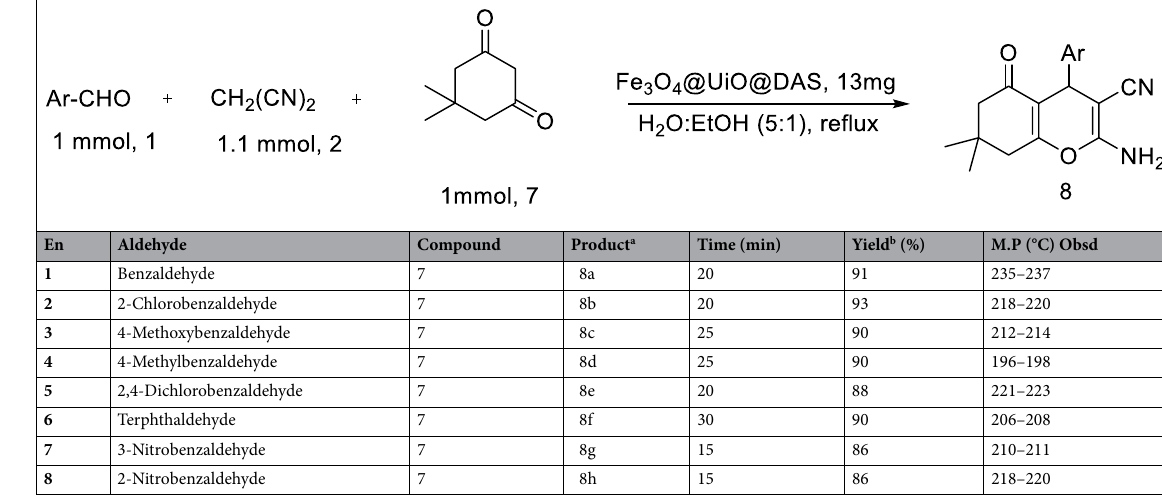
Table 5. Three-component synthesis of different 4 H -chromene (8a–h) via condensation of various aldehydes (1), malononitrile (2) and dimedone (7) in the presence of Fe 3 O 4 @UiO@DAS. Reaction conditions: Aldehyde (1, 1 mmol), Malononitrile (2, 1.1 mmol), dimedone (7, 1 mmol), and Fe 3 O 4 @UiO@DAS (13 mg) at reflux conditions. a All compounds are known and their structures were established from their melting points compared with authentic samples or literature values. b Isolated yield.